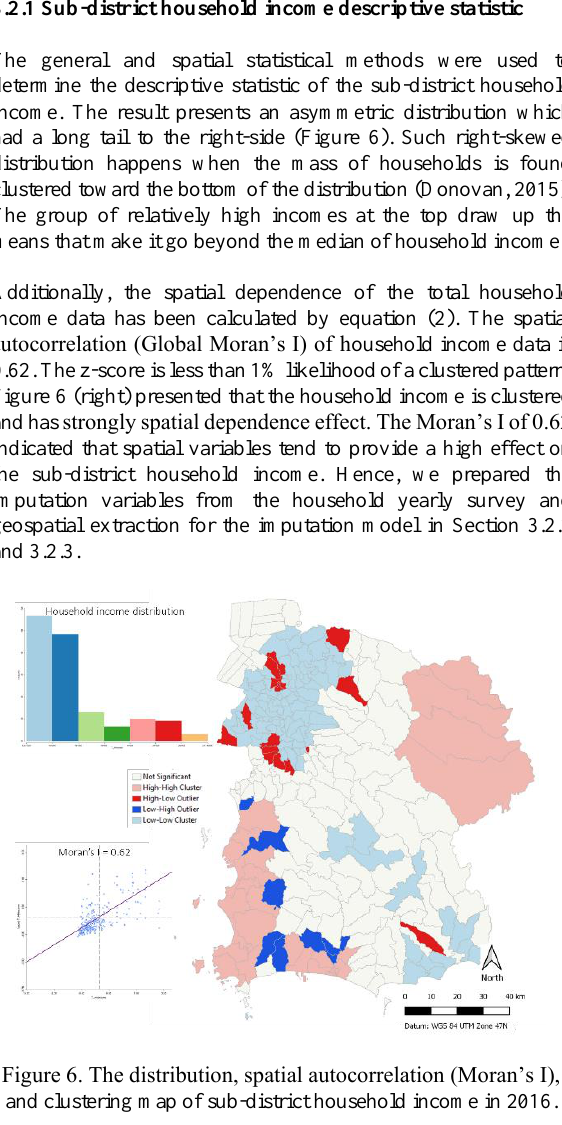
Figure 5. The correlation between night-time light intensity and urban density of 48 sampling sub-districts.